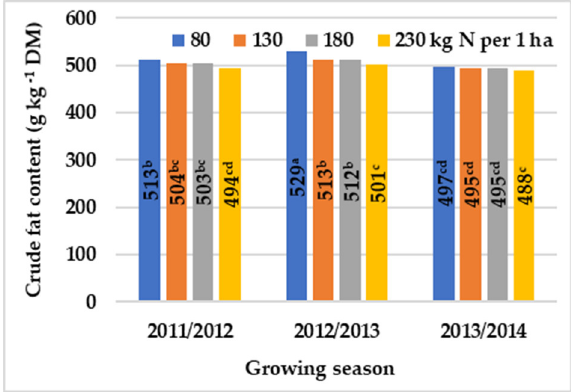
Figure 11. The effect of N rate on the crude fat content of winter oilseed rape seeds, across growing Figure 11. The e ff ect of N rate on the crude fat content of winter oilseed rape seeds, across seasons (2011–2014). Means with the same letters do not differ significantly at p ≤ 0.05 in Tukey`s test.